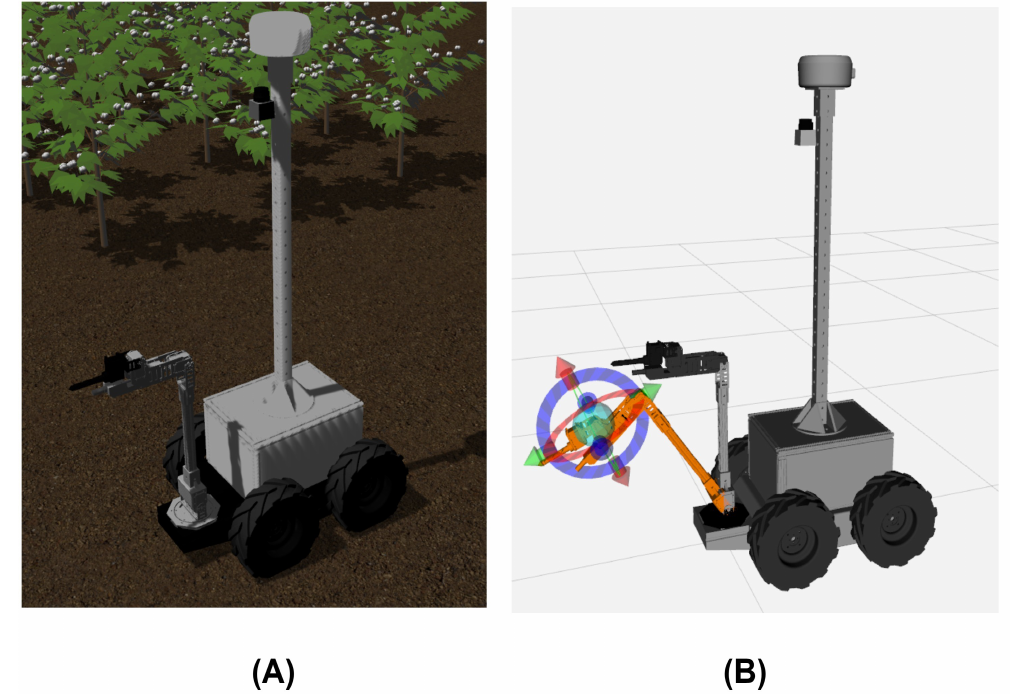
Figure 6. Simulation of the robot in ( A ) Gazebo and ( B ) Moveit RViz Visualizer in Robot Operating System